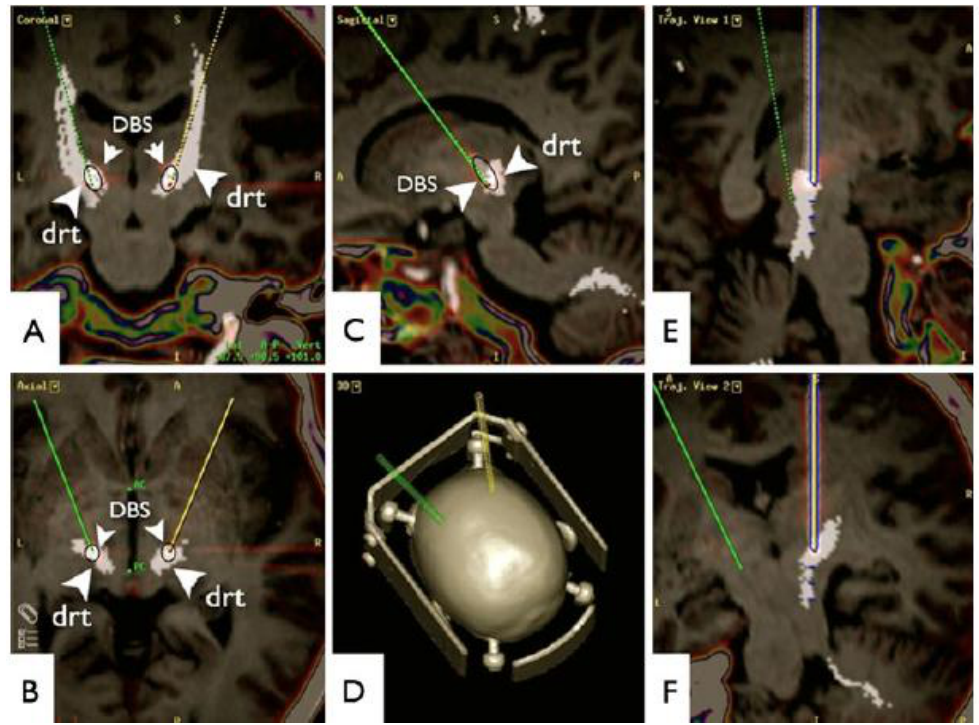
Figure 3. Diffusion tensor imaging fibre tracking-based targeting of the dentato-rubro-thalamic tract (DRT). Superimposition with a postoperative helical computed tomography (artefact from deep brain stimulation electrodes, DBS). ( A ) Coronal; ( B ) axial; ( C ) sagittal views; ( D ) 3D; ( E , F ) Trajectory views of left electrode path. Reprinted from reference [33] with permission of Springer.